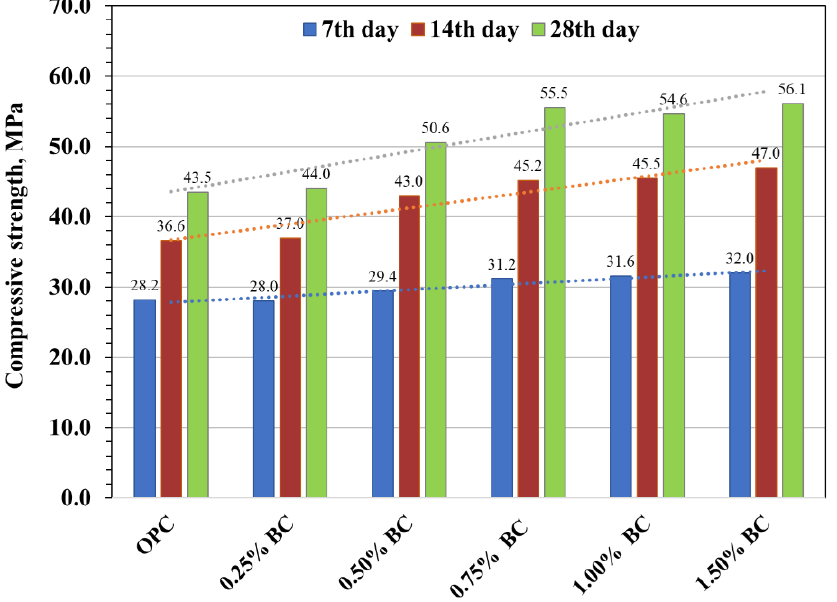
Figure 6. Compressive strength of concrete cylinder specimens.